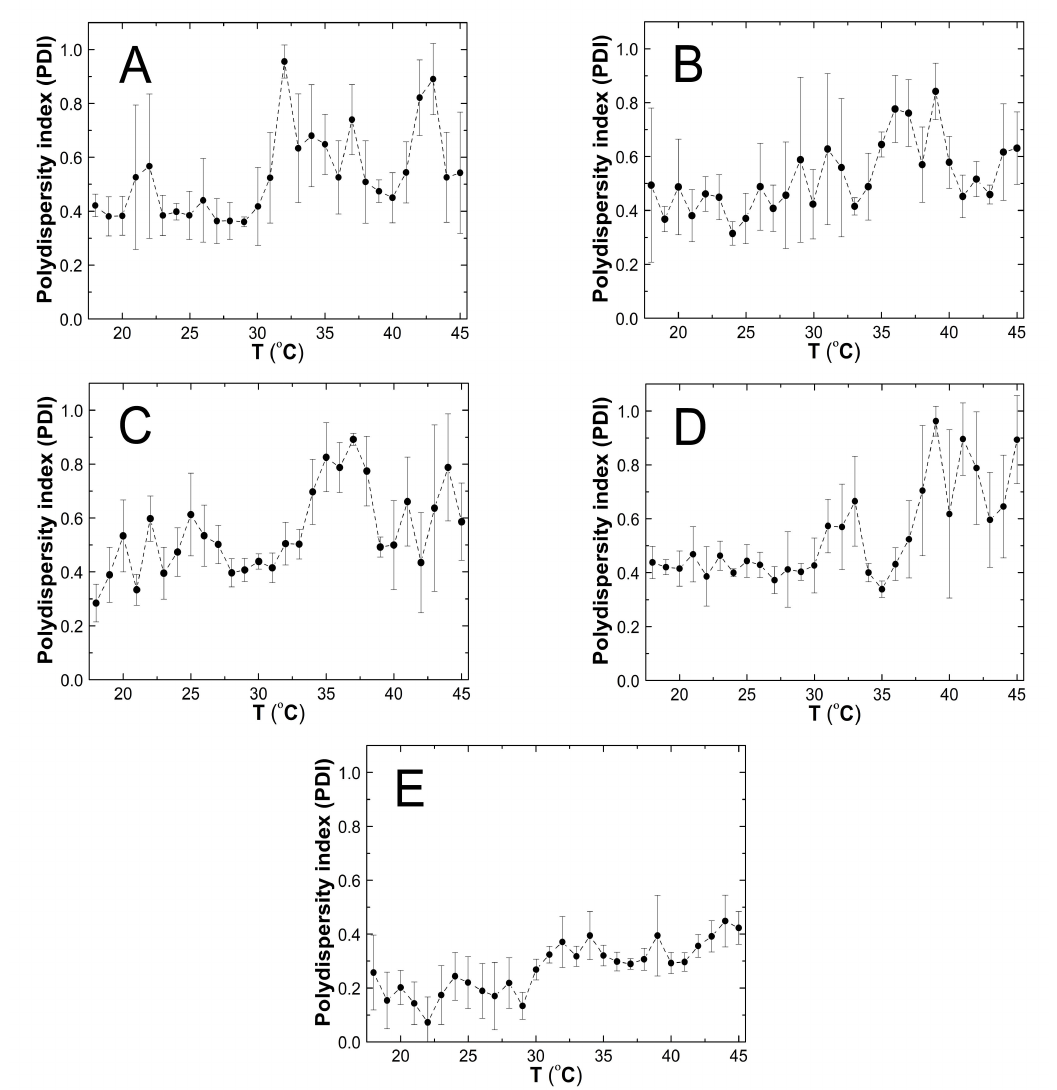
Figure 10. ( A – E ) The influence of temperature on the polydispersity index (PDI) of the PS1 ( A ), PS2 ( B ), PS3 ( C ), PS4 ( D ), and PS5 ( E ) samples, determined by dynamic light